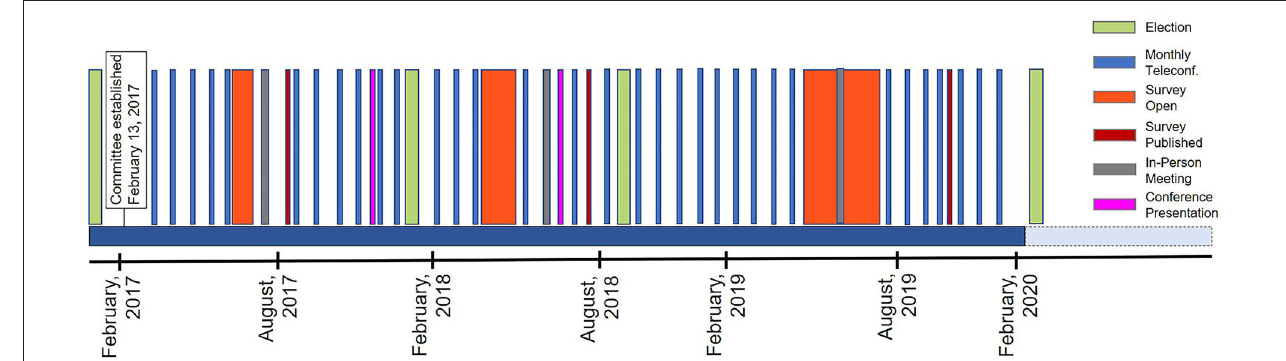
FIGURE 3 | User forum timeline of activities in years 1 through